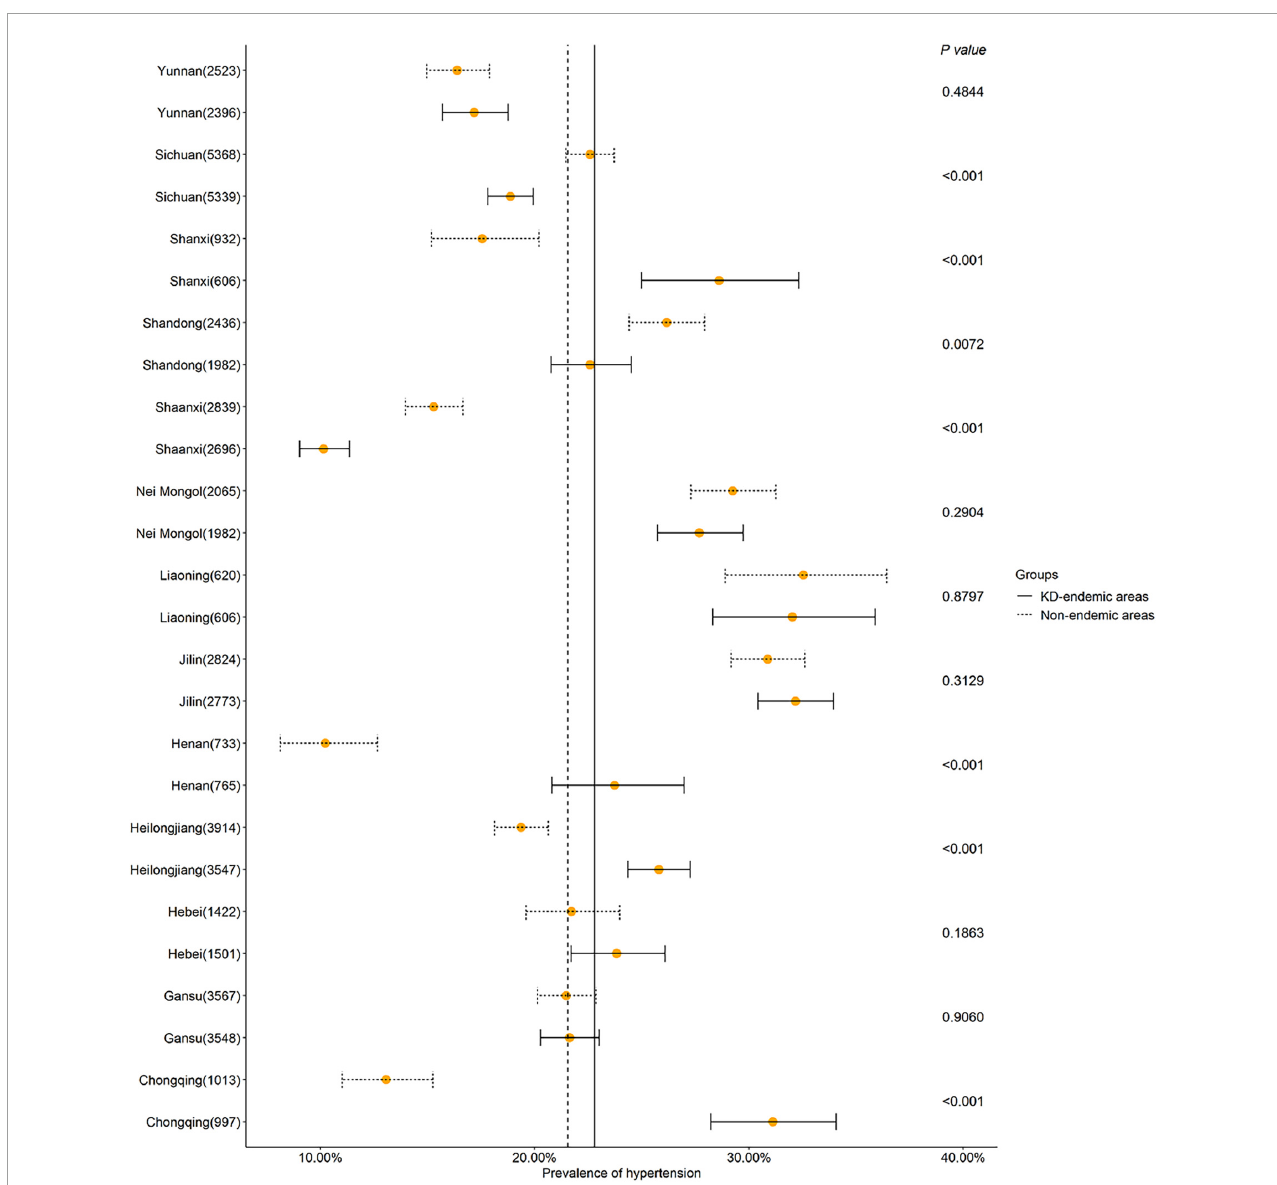
FIGURE4 Hypertension prevalence in KD-endemic and non-endemic areas by province. Forest plots were employed to describe the hypertension prevalence rate at the province level. The prevalence was standardized by age and sex based on the 2012 China Statistical Yearbook. KD, Keshan disease; The number in the bracket represents the total number of participants in each province. The upright solid line indicates the hypertension prevalence in the KD-endemic areas in total. The upright dotted line indicates the hypertension prevalence in the non-endemic areas in total.